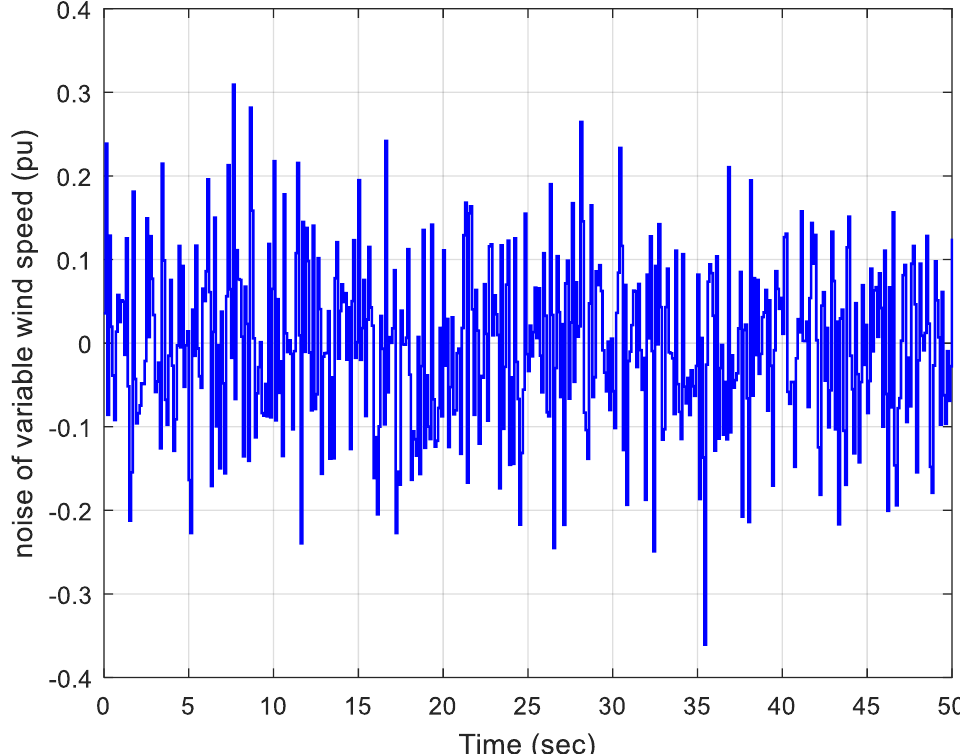
Figure 6. Variable velocity disturbances applied to the studied system.